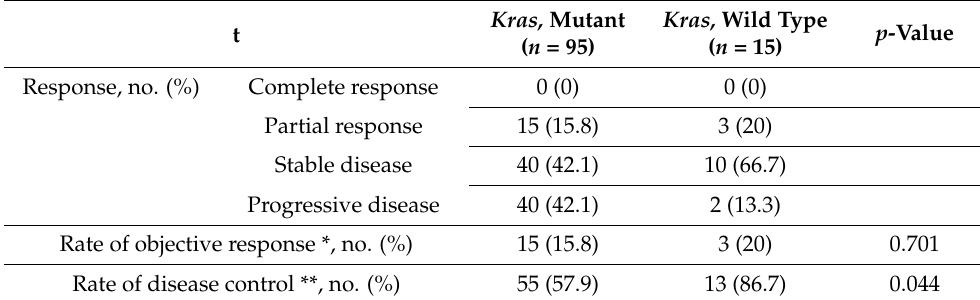
Table 3. Response to first-line chemotherapy with GEM and nab-PTX.